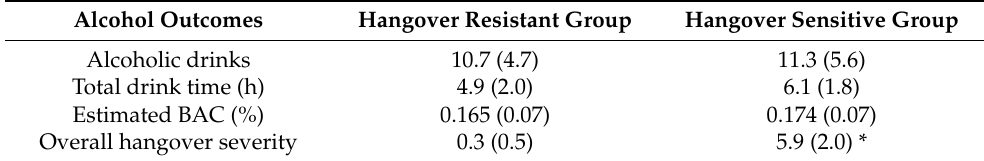
Table 2. Alcohol consumption outcomes on the test day.